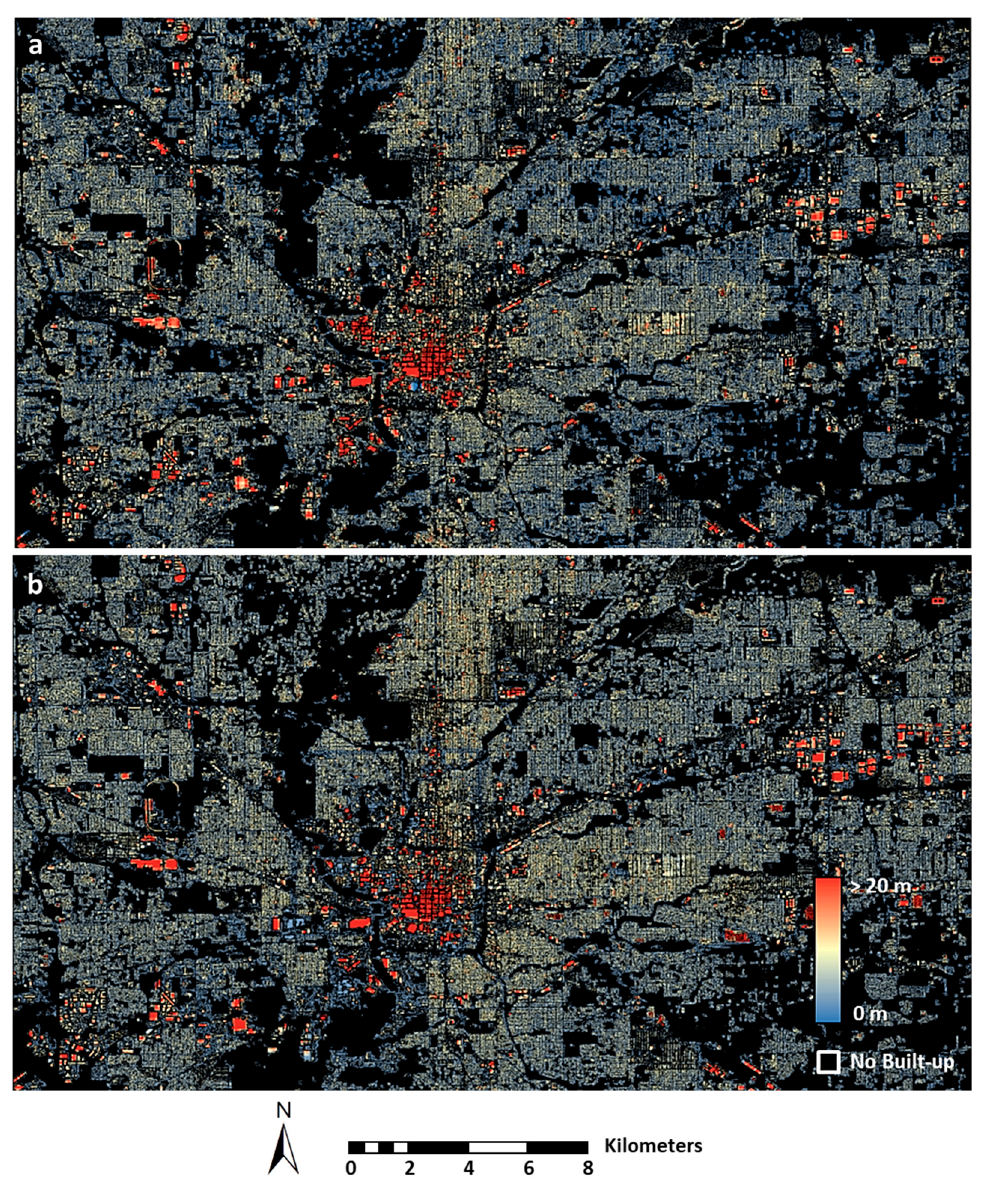
Figure 3. The GUF-3D layer generated for Indianapolis ( a ) in comparison to the reference data available for this region ( b ).